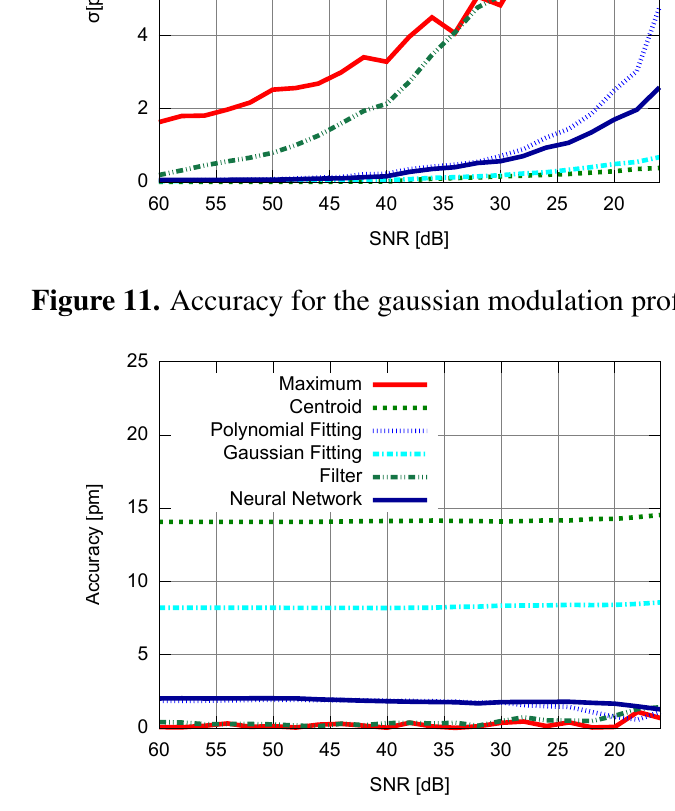
Figure 12. Precision for the gaussian modulation